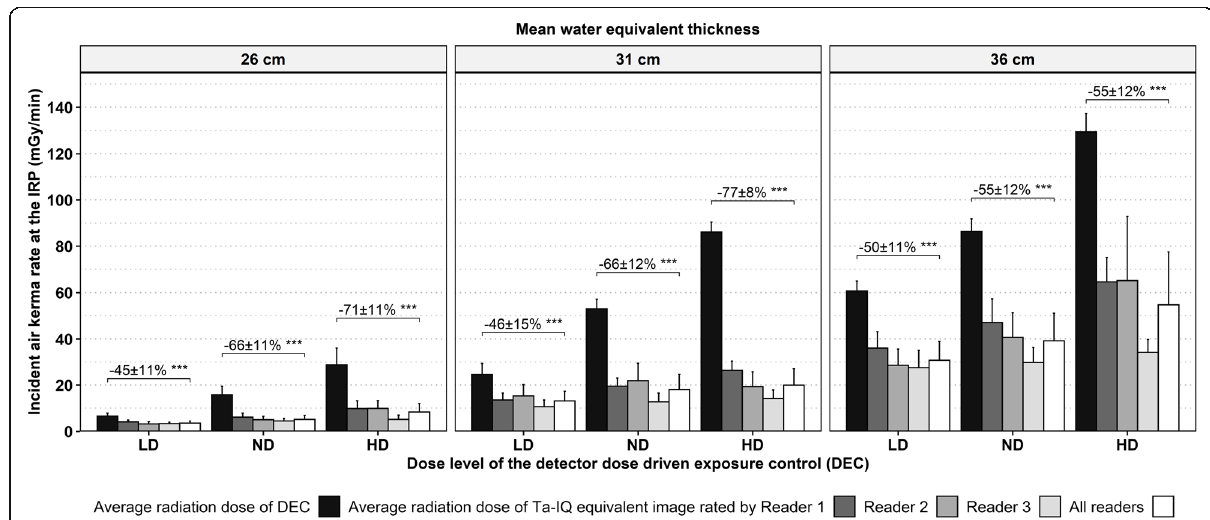
Fig. 4 Incident air kerma at the interventional reference point (IRP) of fluoroscopic images acquired with detector dose driven exposure control (DEC) at three dose levels (LD: Low dose, ND: Normal dose, HD: High dose) and three water equivalent thicknesses, compared to the IRP of the image acquired with Ta-specific contrast-to-noise ratio driven exposure control at comparable image quality of the Ta structures. *** p < 0.001. IRP Interventional reference